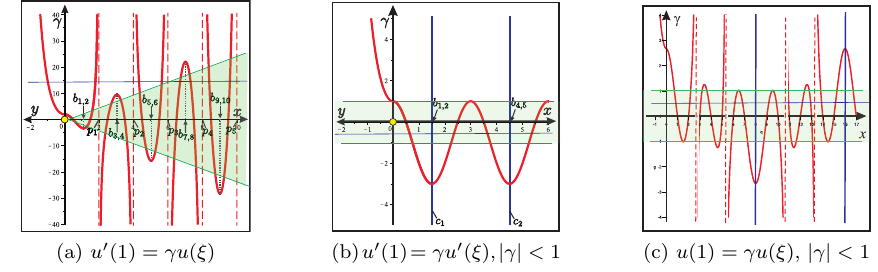
Figure 2. Real CF (Dirichlet BC) and positive